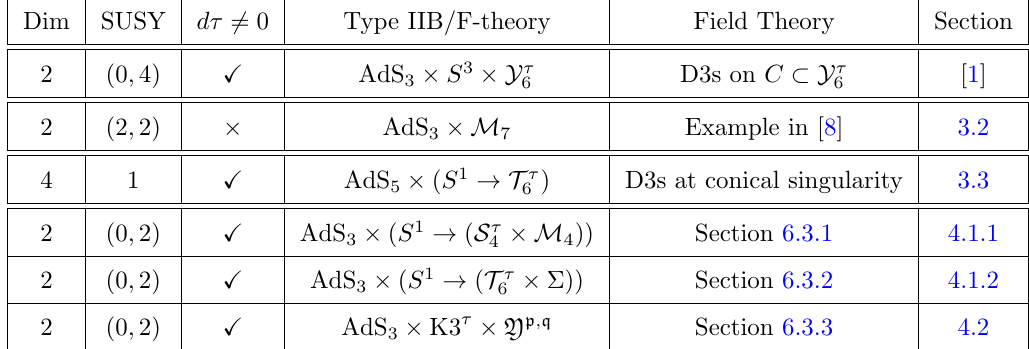
and K3 (cid:28) do they have Ricci-(cid:13)at 6